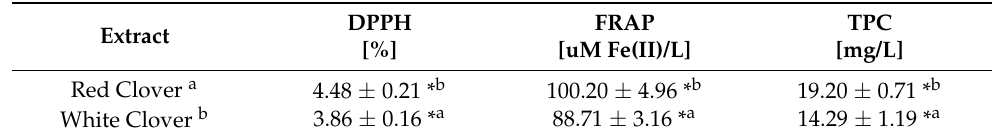
Table 1. Antioxidant potential (DPPH (2.2-diphenyl-1-picrylhydrazyl), ferric reducing antioxidant power (FRAP)), the total polyphenols content (TPC) in red and white clover flower extract (100 ppm). Different letters (a,b) in the columns represent statistically significant differences—* FDR p < 0.05 between particular subgroup, a Red Clover extract, b White Clover